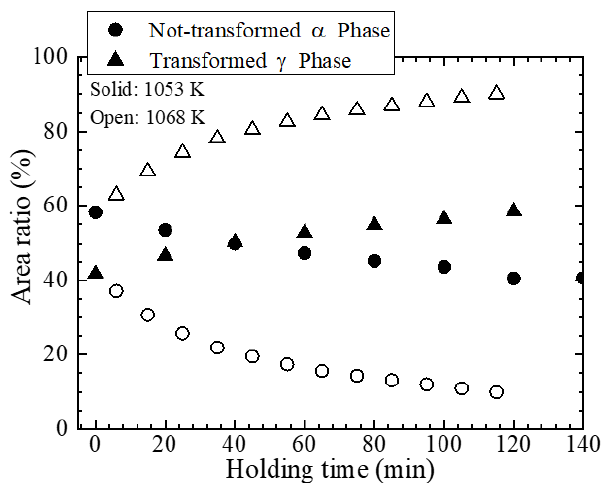
Figure 8. Changes with time in the area ratio of the not-transformed α phase and the transformed γ phase during L treatment at 1053 K and 1068 K.